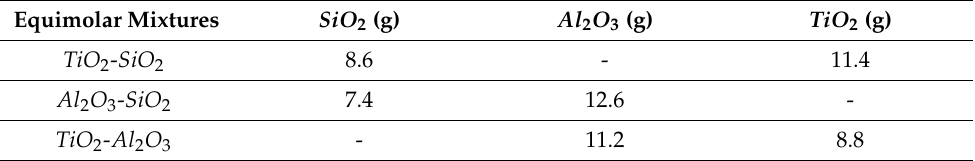
Table 2. Mass composition per 1–1 equimolar type of mixed oxide. Nanoparticle free-standing size is 12 nm, 40–50 nm, and 25 nm for SiO 2 , Al 2 O 3 , and TiO 2 , respectively. Equimolar